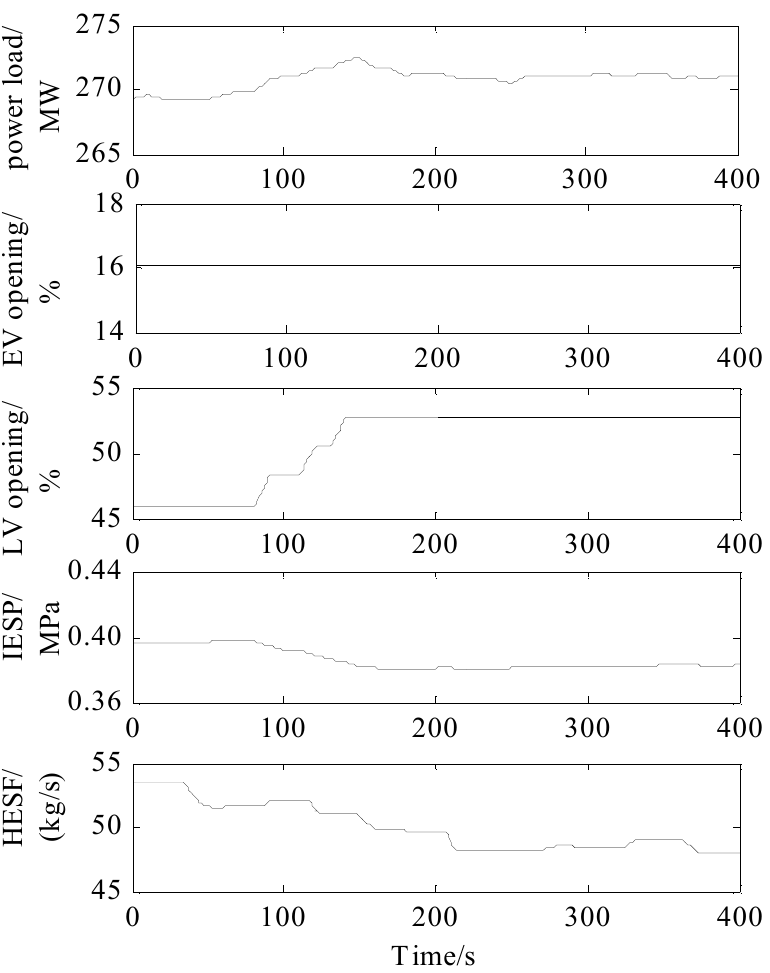
Figure 5. Dynamic response to LV opening.